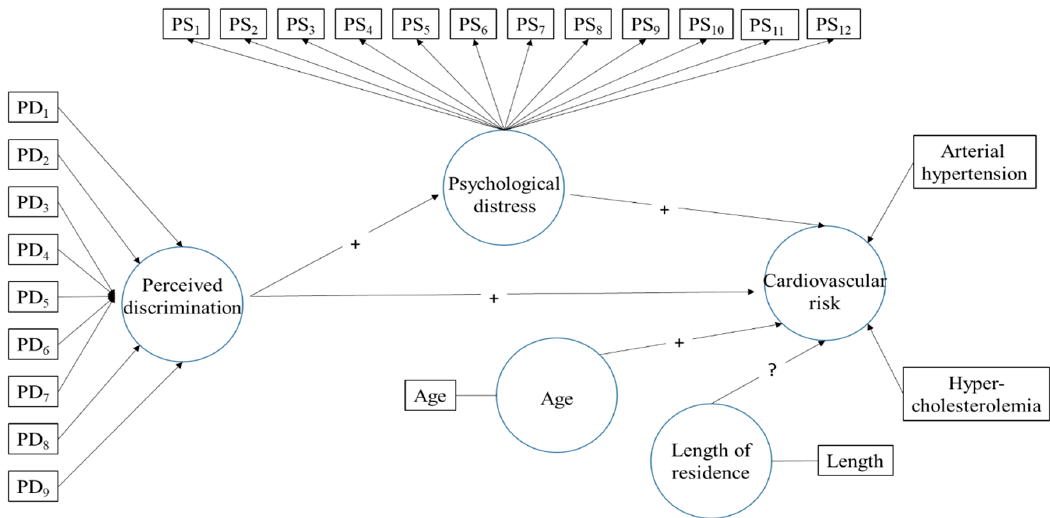
Figure 2. Path diagram of measurement model and structural model. PD 1 -PD 9 are the nine items of perceived discrimination questionnaire and PS 1 -PS 12 are the twelve items of psychological distress questionnaire (See Tables 1 and